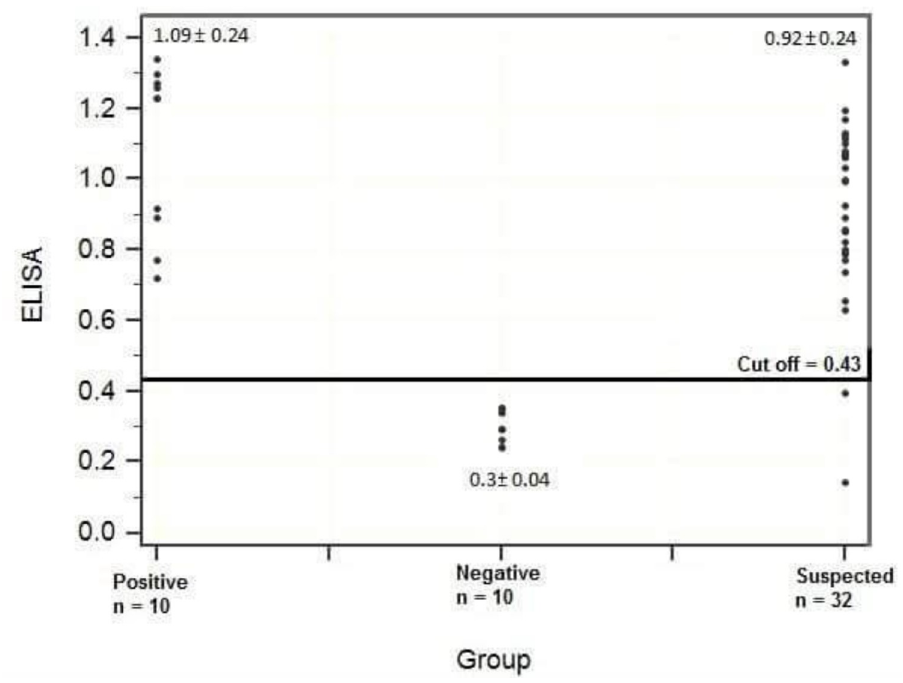
Fig 2. Levels of C . philippinensis coproantigen in different study groups.